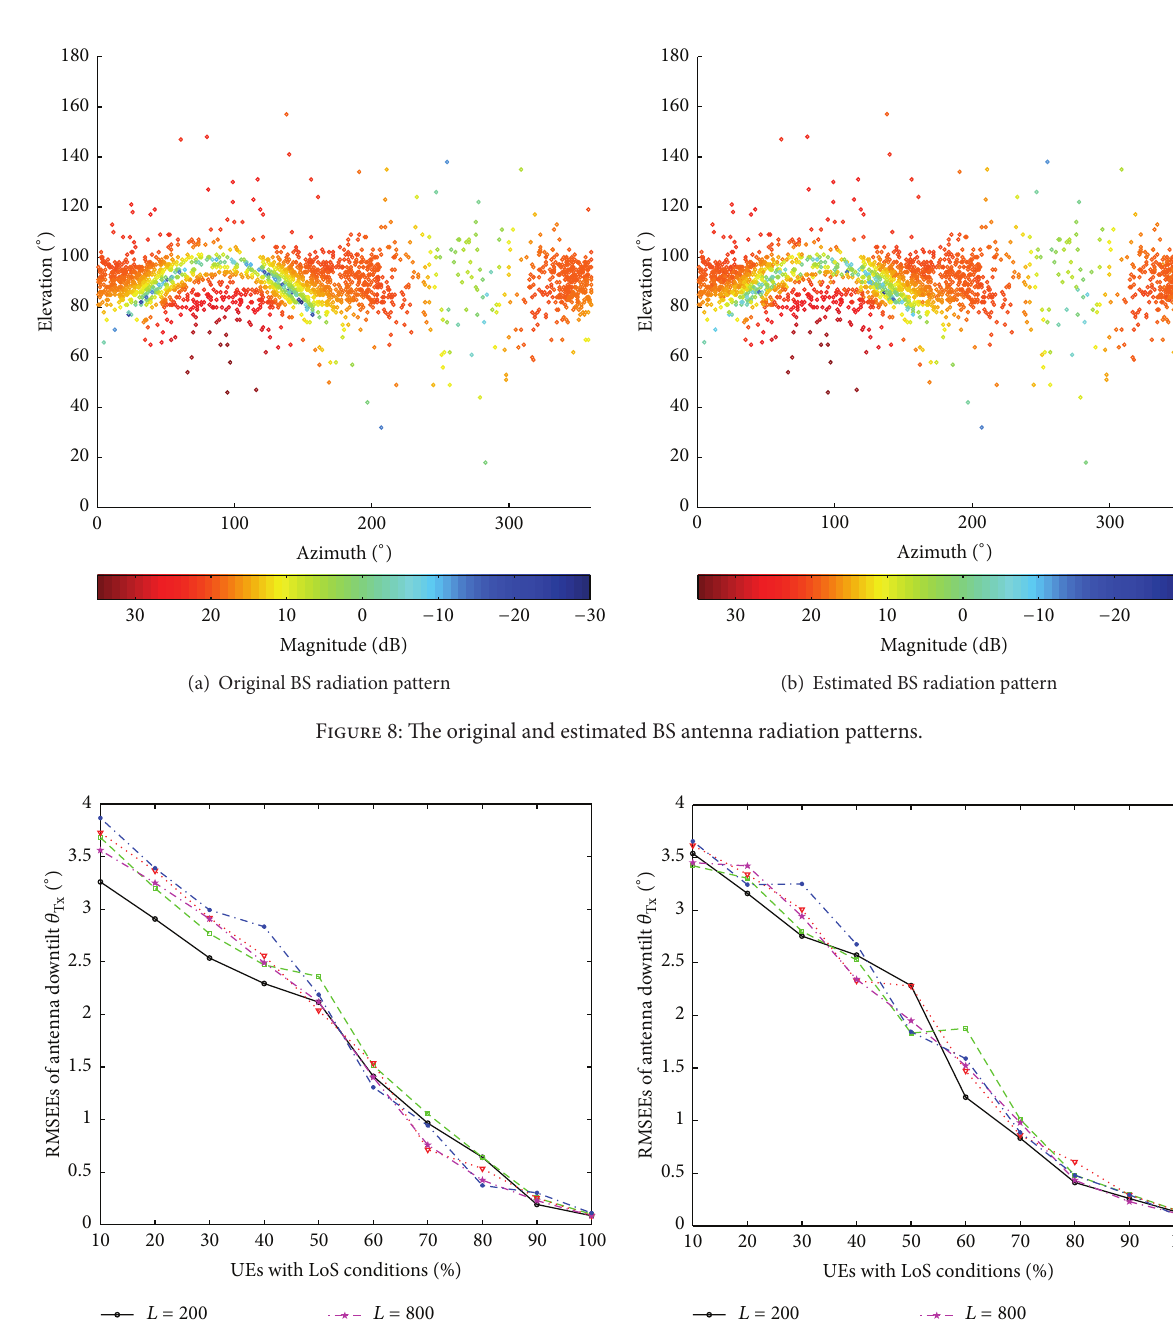
appears more blurred than the true counterpart at the low- gain portions of both patterns which are colored in green or blue in Figures 8(a) and 8(b). This may be due to